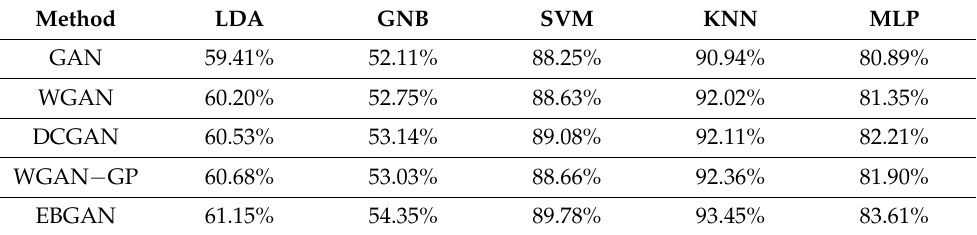
Table 6. Classification accuracy of each classification model under different generation